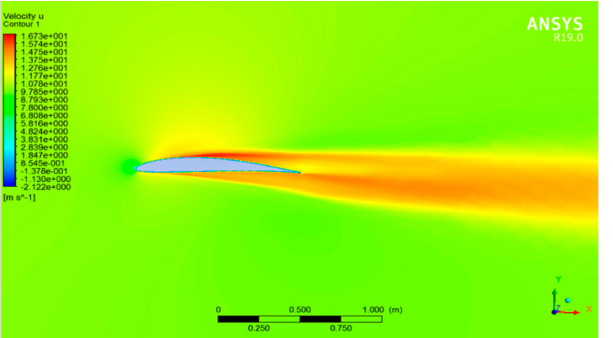
Figure 8. Contour plot of velocity vector for cruise conditions (15 m/s) at zero AOA. The variation of the lift and drag forces with the change in angle of attack (0–100 ◦ ) and airstream velocity (0–15 m/s) is captured in Figure 9. As seen in the figure, a positive lift force is generated in the fixed-wing flight phase, and a positive drag force is generated at the VTOL phase due to changes in the angle of attack from 0 ◦ to 90 ◦ .